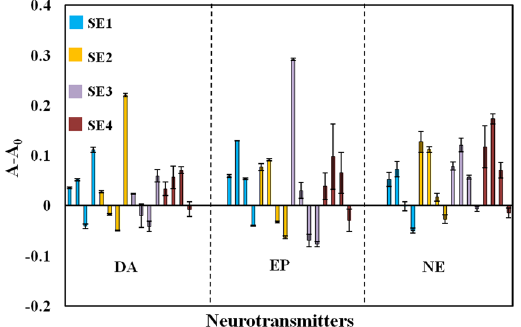
Figure 1. Unique response pattern bar plots for dopamine, epinephrine and norepinephrine at concentration of 20 µ g mL − 1 in four spectrum wavelengths (i.e., 520, 850, 950 and 1000